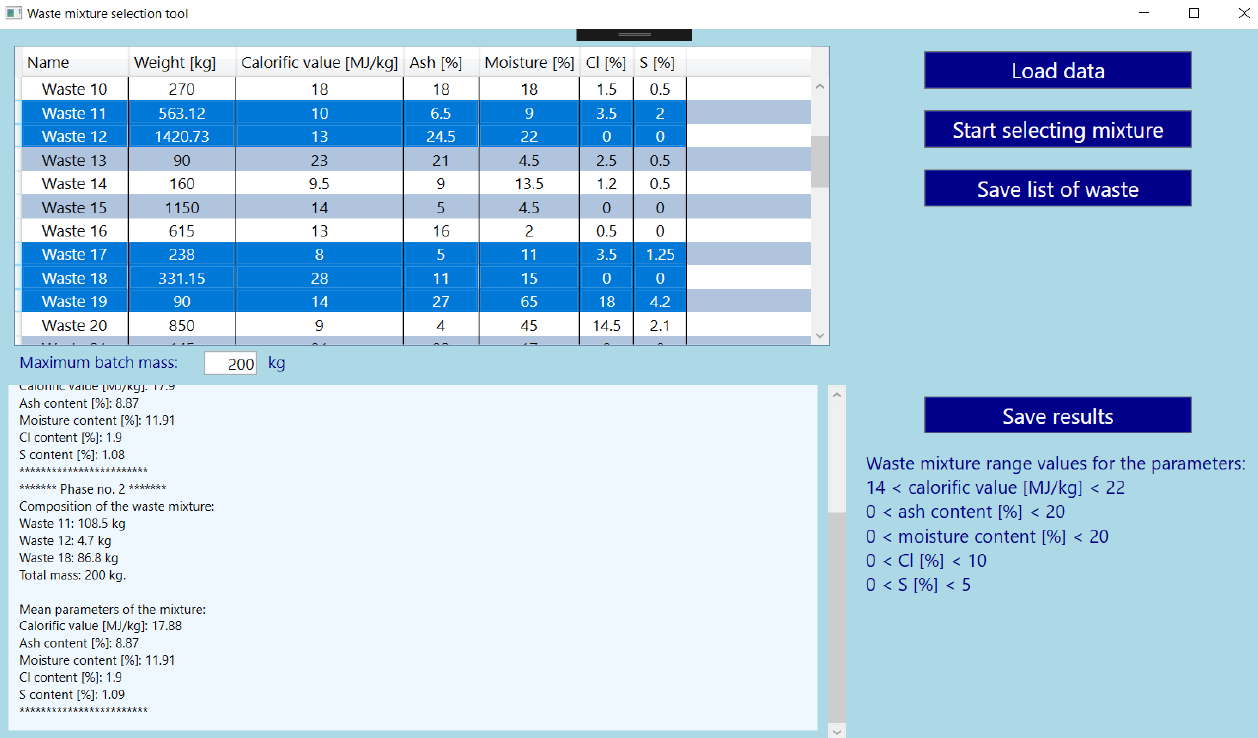
Figure 2. Creating a mixture of the waste portion.